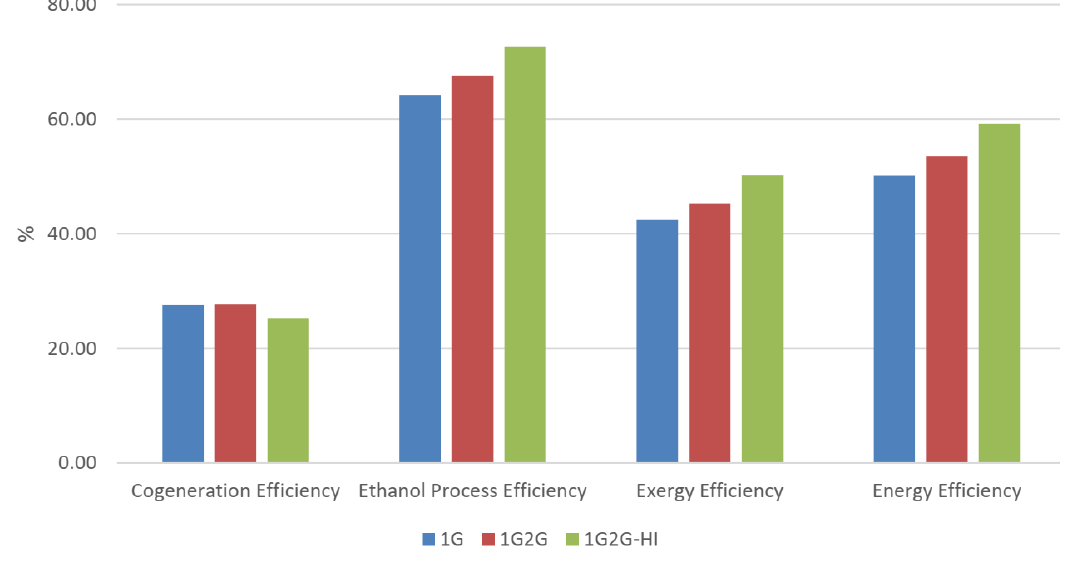
Figure A5. E ffi ciency comparison for each configuration. Figure A5. Efficiency comparison for each configuration. Table A10. Unit exergy cost and exergy efficiency definitions.